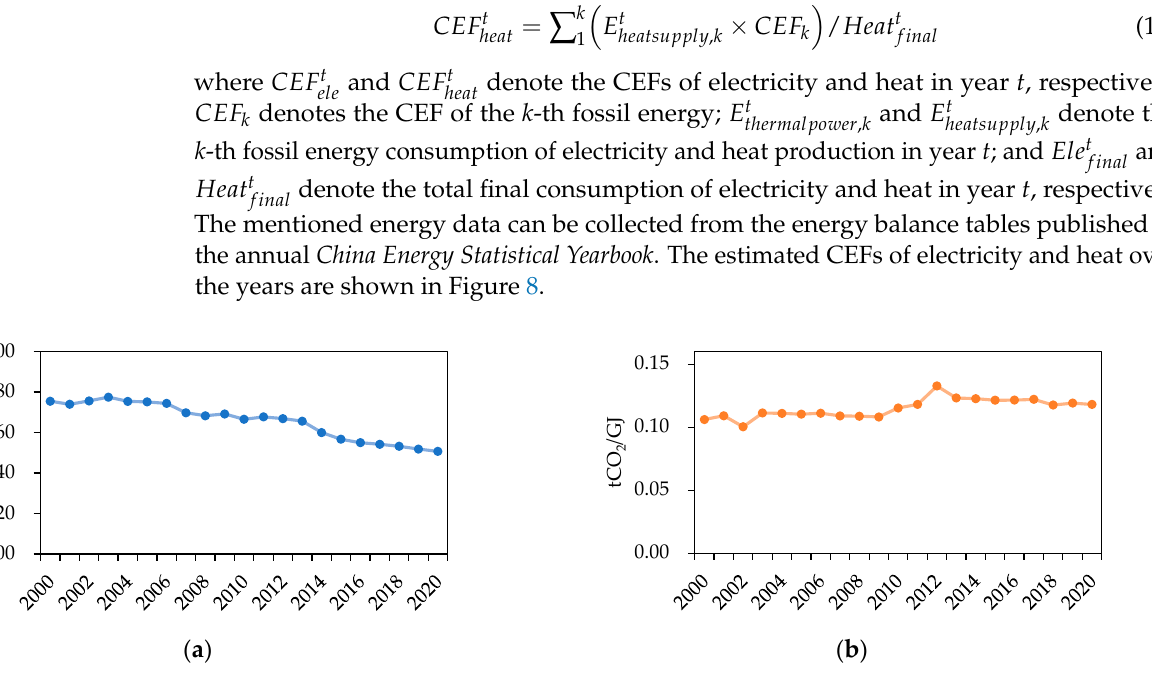
Figure 8. The dynamic CEFs of secondary energies. ( a ) The CEF of electricity; ( b ) The CEF of heat.